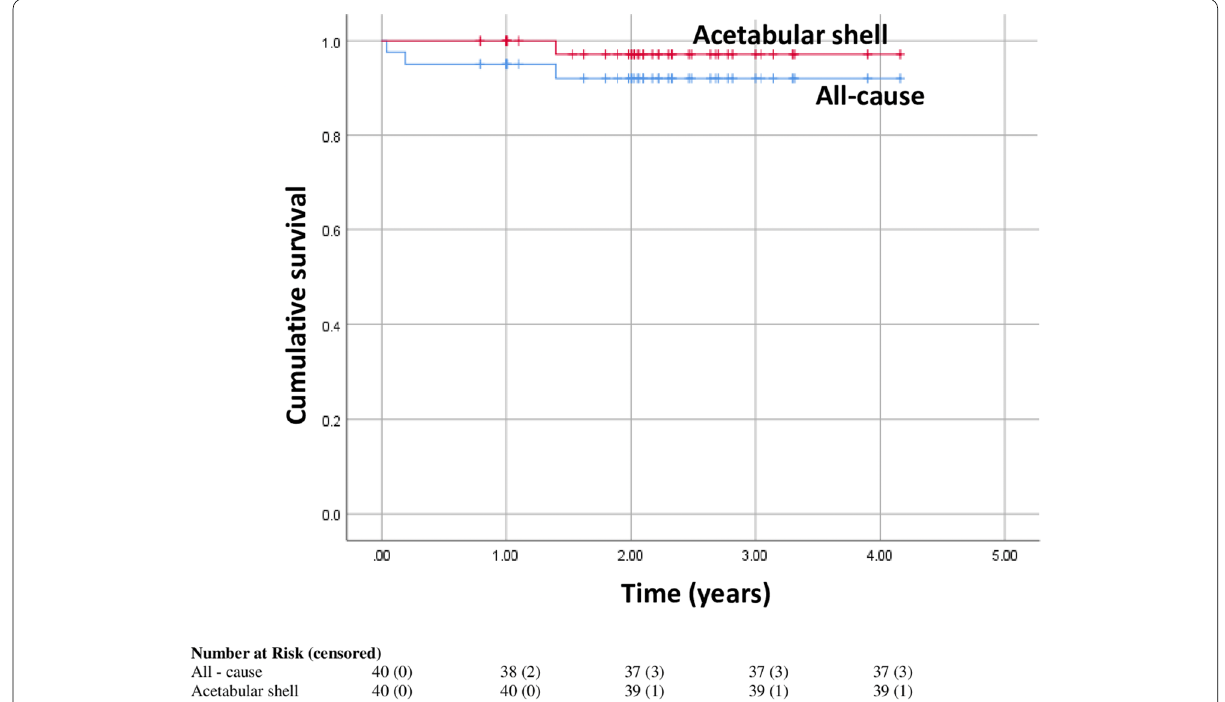
Fig. 4 Kaplan-Meier survivorship curve for all cause revision and acetabular cups in revision total hip arthroplasty patients with an at least 1-year